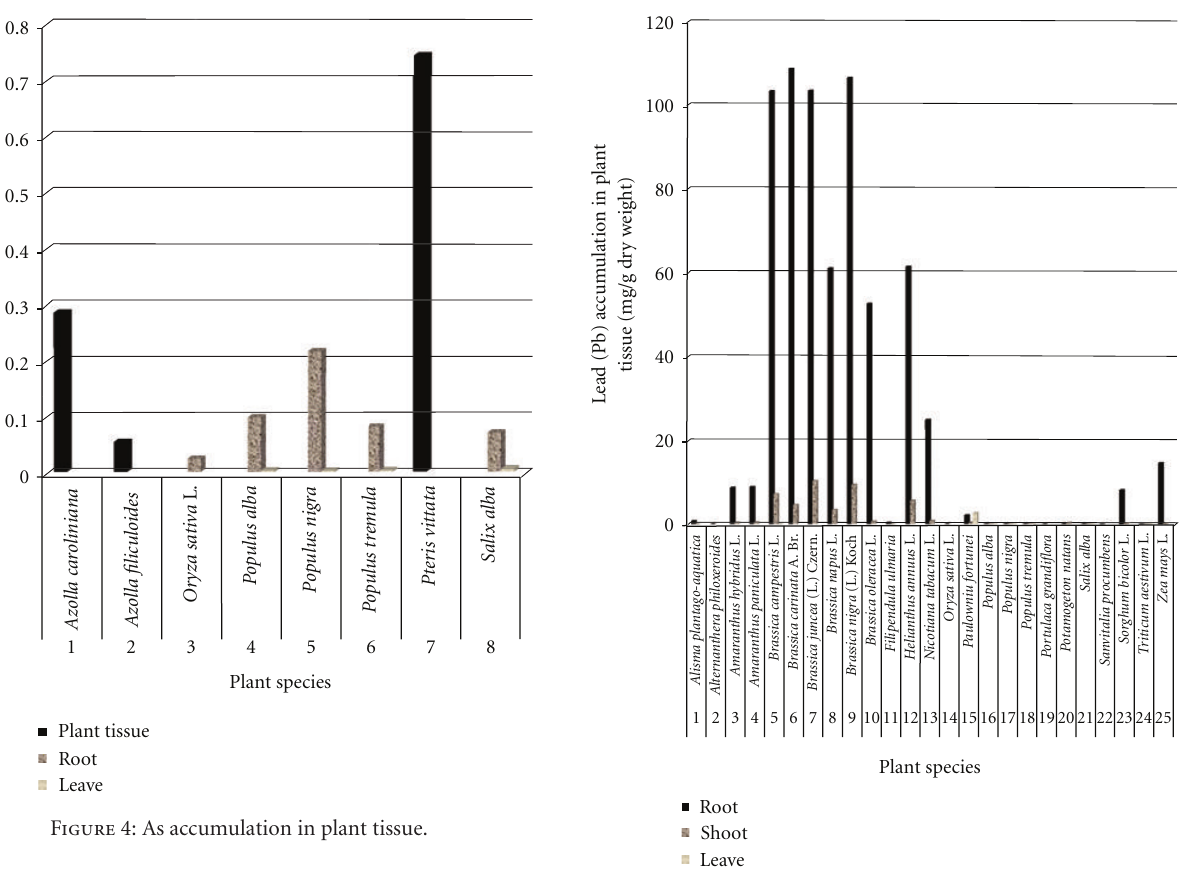
Figure 5: Pb accumulation in plant